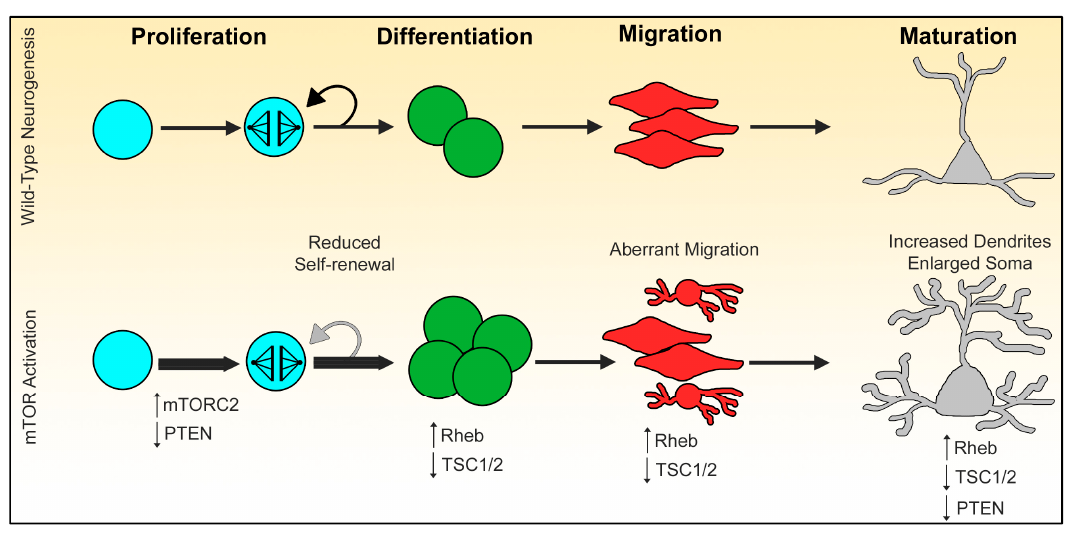
Figure 2. Effects of mTOR activation during neurogenesis. Neural stem cells (blue) undergo proliferation and either give rise to more stem cells (self-renewal) or daughter cells (green, differentiation). Activation of mTORC2 promotes neural stem cells (NSC) cell cycle entry through Akt. Hyperactivation of mTORC1 results in diminished self-renewal, favoring differentiation and lineage expansion. Daughter cells then migrate (red) from proliferation zones to their terminal positions. Activation of mTORC1 results in aberrant migration of daughter cells. Upon reaching their terminal positions, newly born neurons (gray) extend neurites and properly form dendritic arbors. Cells with high levels of mTORC1 activity can severely alter dendrite formation and synaptic integration. Upward pointing arrows indicate increased activity of designated genes or proteins. Downward pointing arrows indicate decreased activity or knockdown of designated genes or proteins.